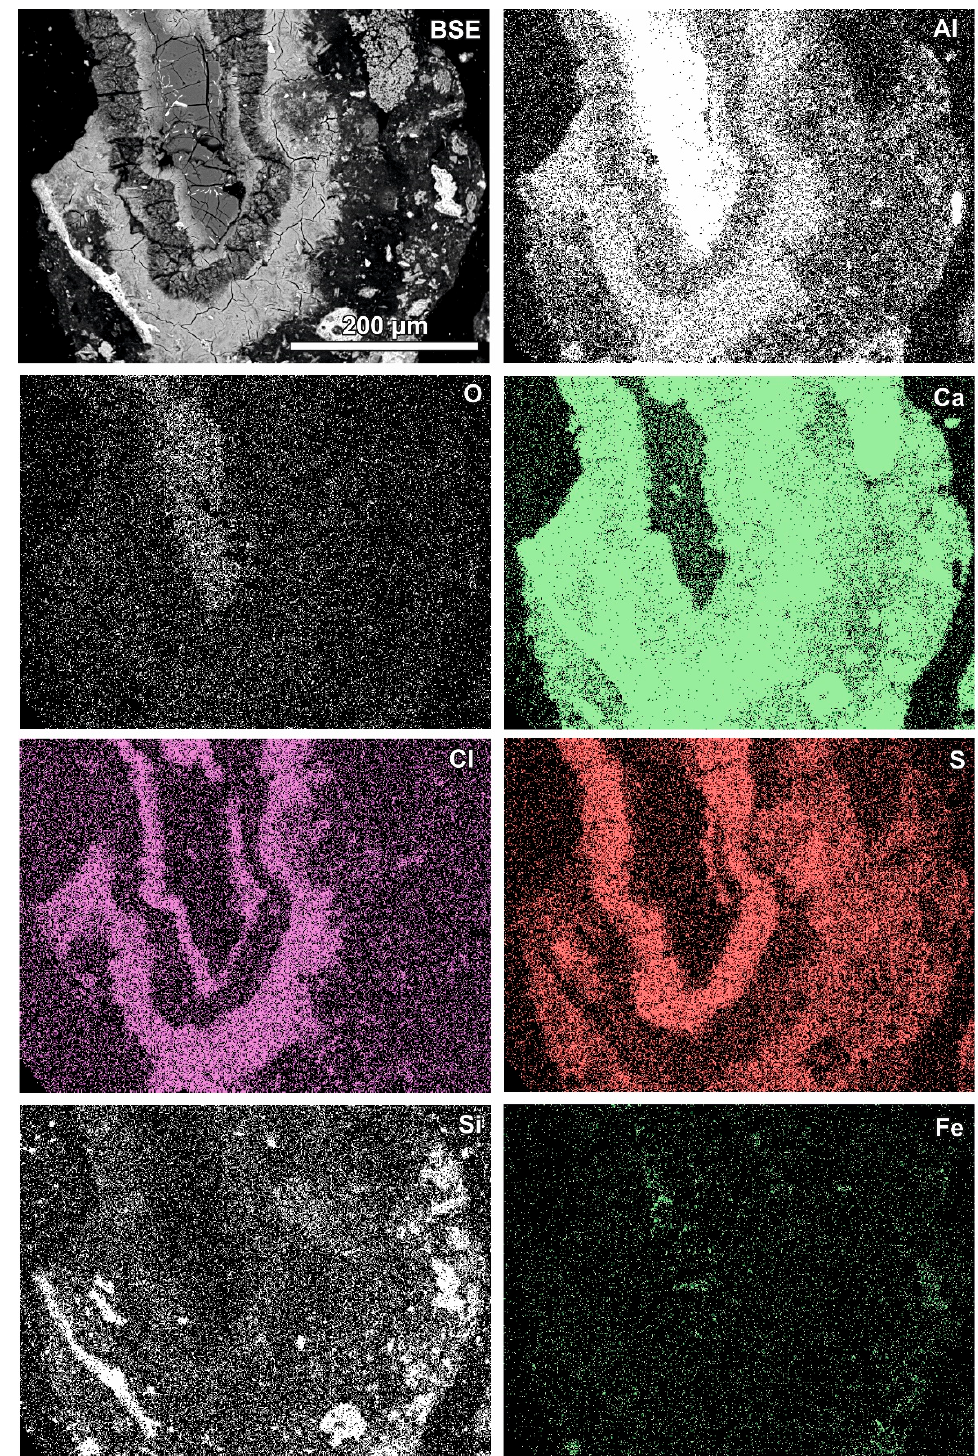
Figure 7. SEM BSE image of the reaction zone and distribution of selected elements—sample RZ4.